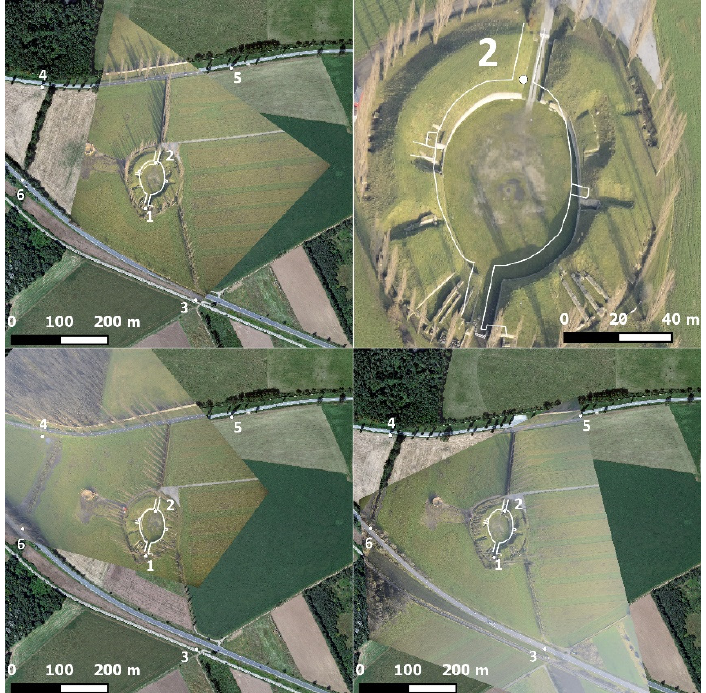
Figure 7. ( upper left ) image 1 (46mm focal length; 44.9° pitch; 7.1° roll and 69.1° yaw); ( upper right ) zoom of image 1; ( lower left ) image 2 (50 mm focal length; 31.19° pitch; 4.21° roll and 162.68° yaw); ( lower right ) image 3 (32 mm focal length; 32.5° pitch; 3.1° roll and − 135.8° yaw).